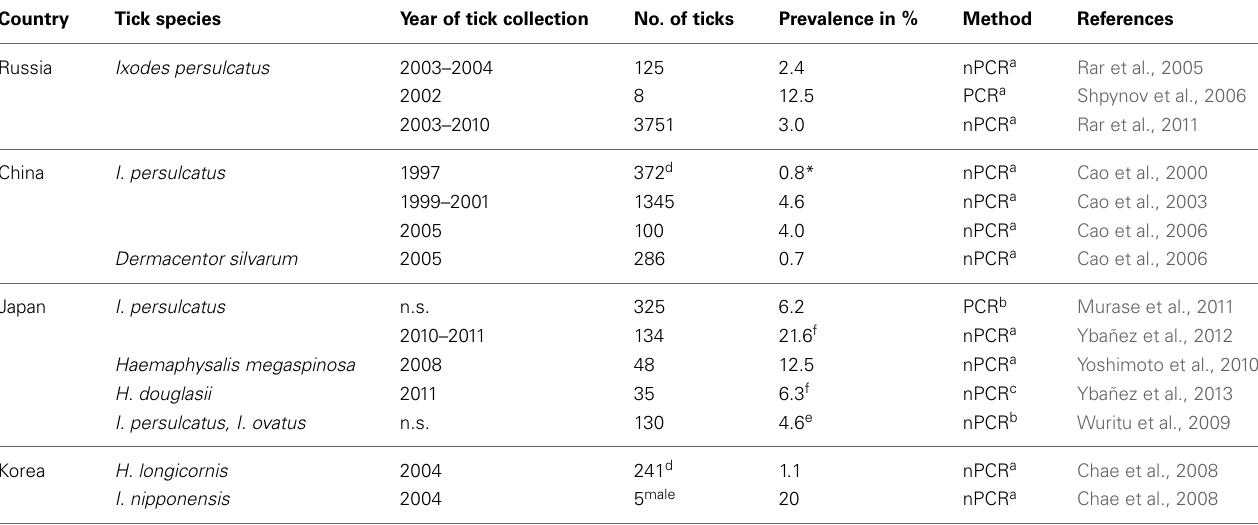
Table 5 | Molecular prevalence studies of Anaplasma phagocytophilum in questing ticks in Asia*.